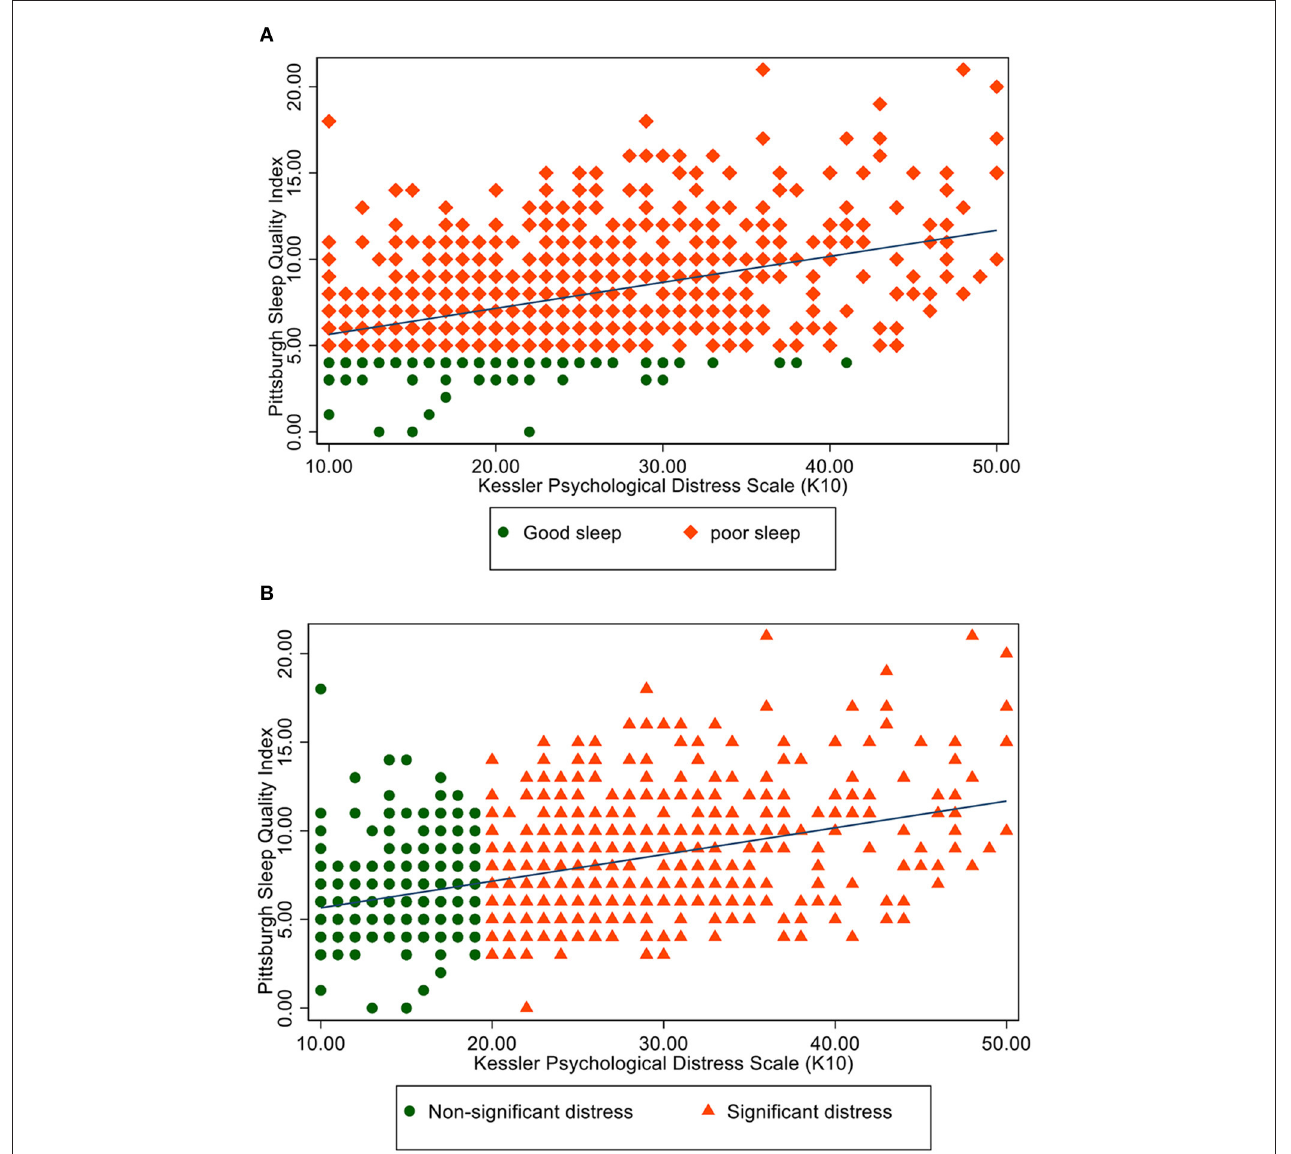
FIGURE 2 | (A) Scatter plot of PSQI and K-10 scores in patients with poor vs. good sleep. (B) Scatter plot of PSQI and K-10 scores between participants with significant and non-significant distress.